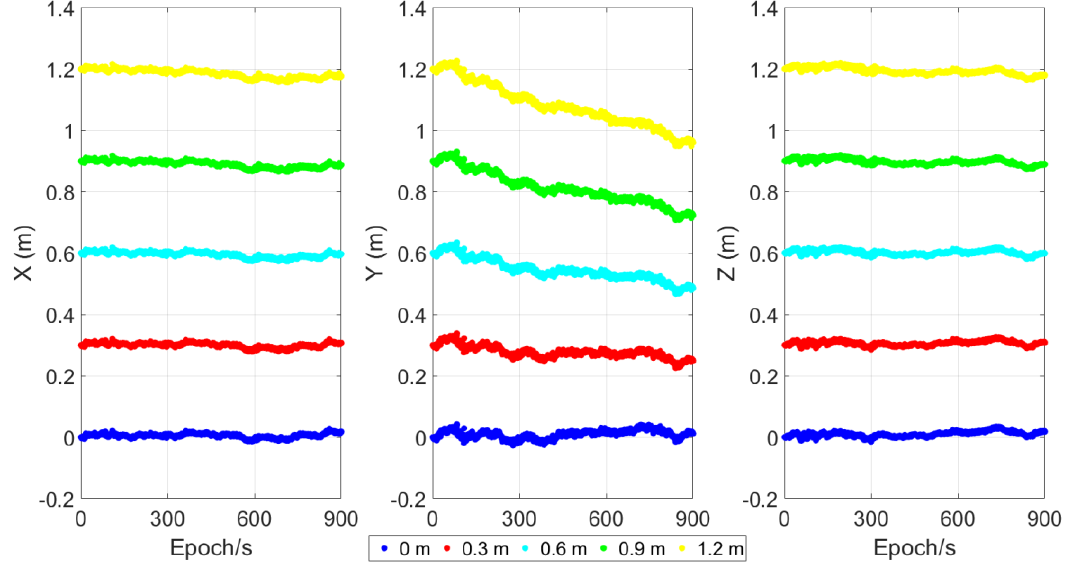
Figure 17. Positioning error in the X/Y/Z direction with different initial coordinates.